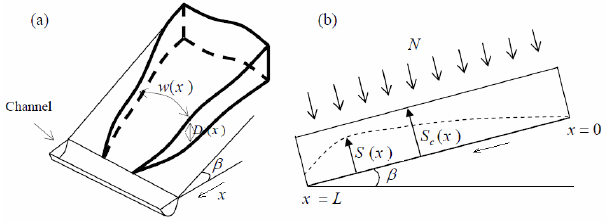
Fig. 1. (a) A three dimensional view of a convergent hillslope over- lying a straight bedrock profile, (b) a definition sketch of the cross section of a one-dimensional hillslope aquifer overlying a bedrock with a constant bedrock slope angle (after Talebi et al.,